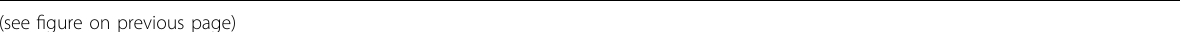
Fig. 4 Gene co-expression (WGCNA) and transcription factor binding motif ( RcisTarget ) analyses. A WGCNA cluster dendrogram visualising the gene co-expression modules identi fi ed in the microarray meta-analysis. These modules are active in at least one of the endothelial cell types. The grey module contains genes unassigned to any module due to low correlative values. B Heatmap and clustering of the gene set variation analysis (GSVA) activity scores for each of the modules and for each of the cell types. Module colours correspond with those from the cluster dendrogram in A . Black box identi fi es module activities in LSECs. C Boxplots of the GSVA enrichment scores for each of the modules, comparing LSECs to all other endothelial cell types. D Cytoscape visualisation of the LSEC-speci fi c immune response modules. Edges indicate a regulatory link identi fi ed by RcisTarget . TF node size relates to the number of downstream targets. For the sake of simplicity, only nodes of the 20 most differentially expressed downstream targets are shown for each TF. Nodes were coloured according to their module colour. TFs belonging to other modules but with a k ME > 0.5 for either the brown, red, or green modules were included as well and coloured accordingly. Circular (square) nodes represent genes that are higher (lower) expressed in LSECs compared to ETV2-ECs. E Enrichment of TF binding motifs was calculated for each of the WGCNA gene co- expression modules. Each dot represents an enriched TF binding motif with the x -axis indicating the RcisTarget network enrichment score (NES) and the y -axis indicating the fraction of genes in the respective module that has binding motifs for the respective gene. For genes with multiple enriched motifs, only the motif with the highest NES is shown. Top TFs are highlighted in red.